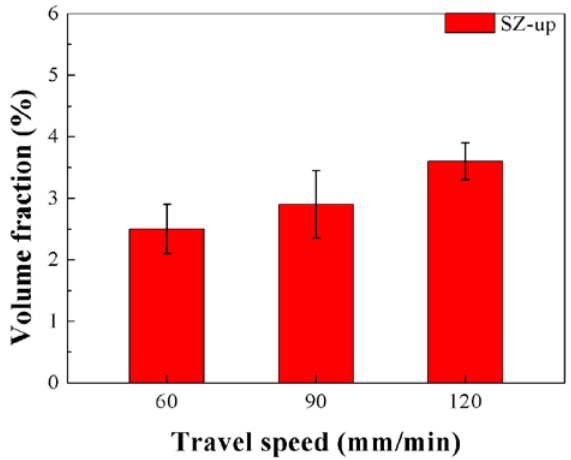
Figure 11. Effect of the travel speed on the relative content of the remaining Mg 2 Sn phase in SZ-up regions of the FSP Mg–6Sn–2Zn samples.